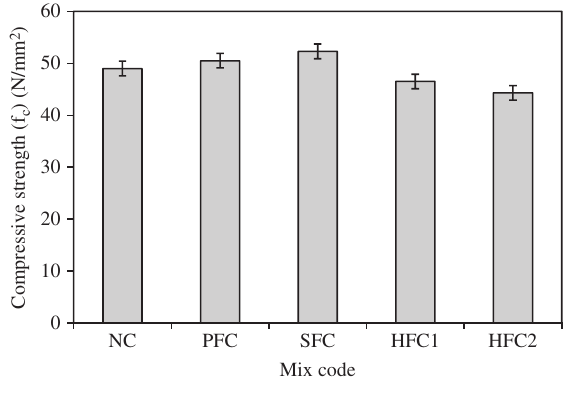
Figure 1 Compressive strength for different fi ber